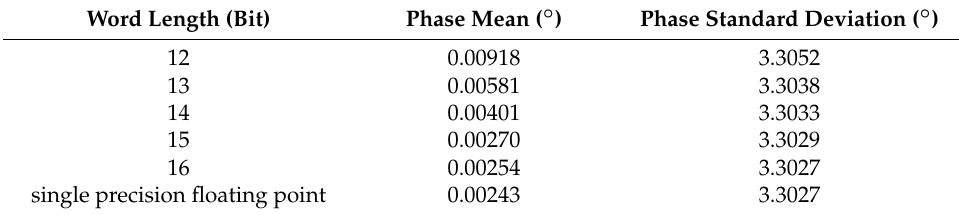
Table 6. Actual scene (overall region) phase information assessment for different FFT processing